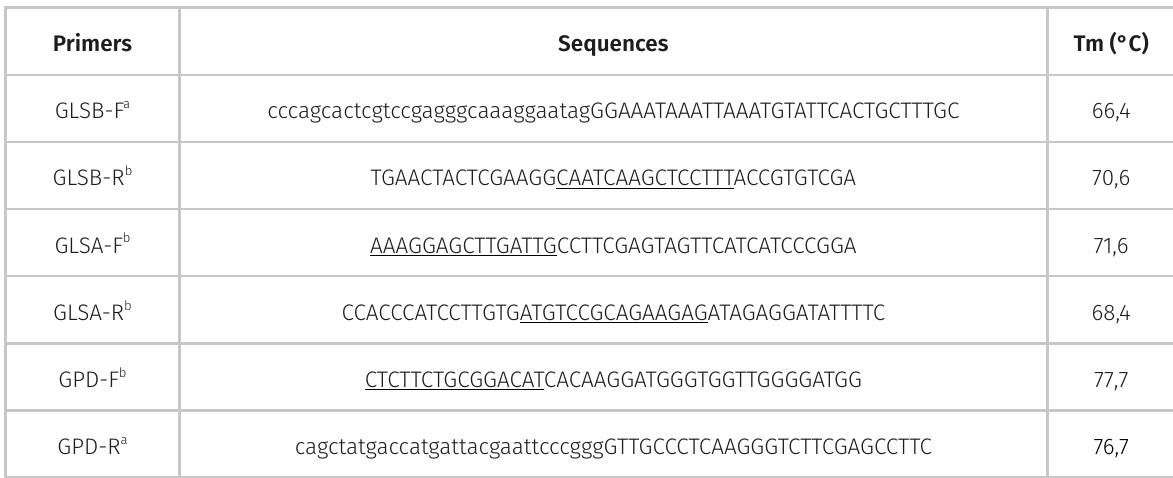
Table I. Nucleotide sequence and TM (melting temperature) of overlapping primers to obtain the plasmid